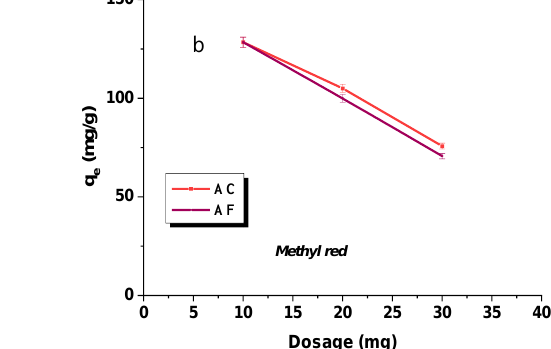
Figure 7. Effect of dosage on the adsorption of methylene blue ( a )/methyl red ( b ) on activated car- bon.